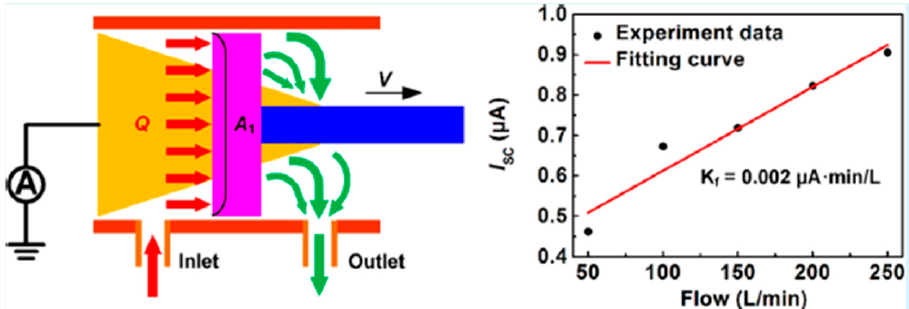
Figure 5. Left: schematic diagram of the triboelectric sensor. Right: the relationship between current Figure 5. Left : schematic diagram of the triboelectric sensor. Right : the relationship between current output produced and flow rate through the actuator during the extension phase output produced and fl ow rate through the actuator during the extension phase [57] .